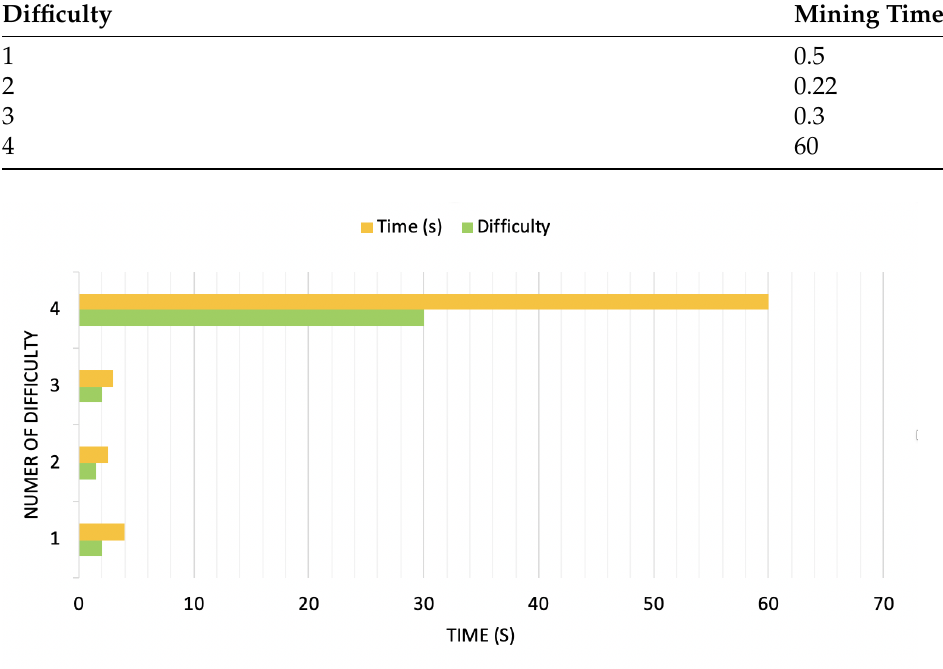
Table 7. Differences between block one mining time and difficulty.